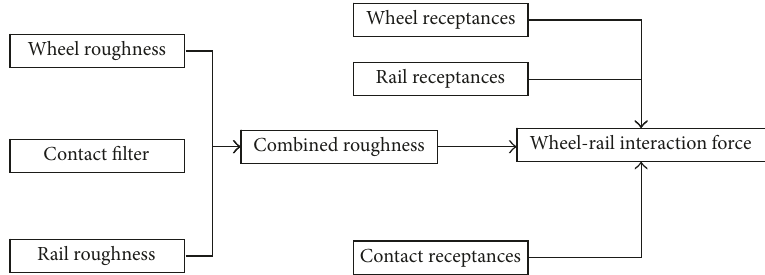
Figure 6: Framework of theoretical model of wheel-rail